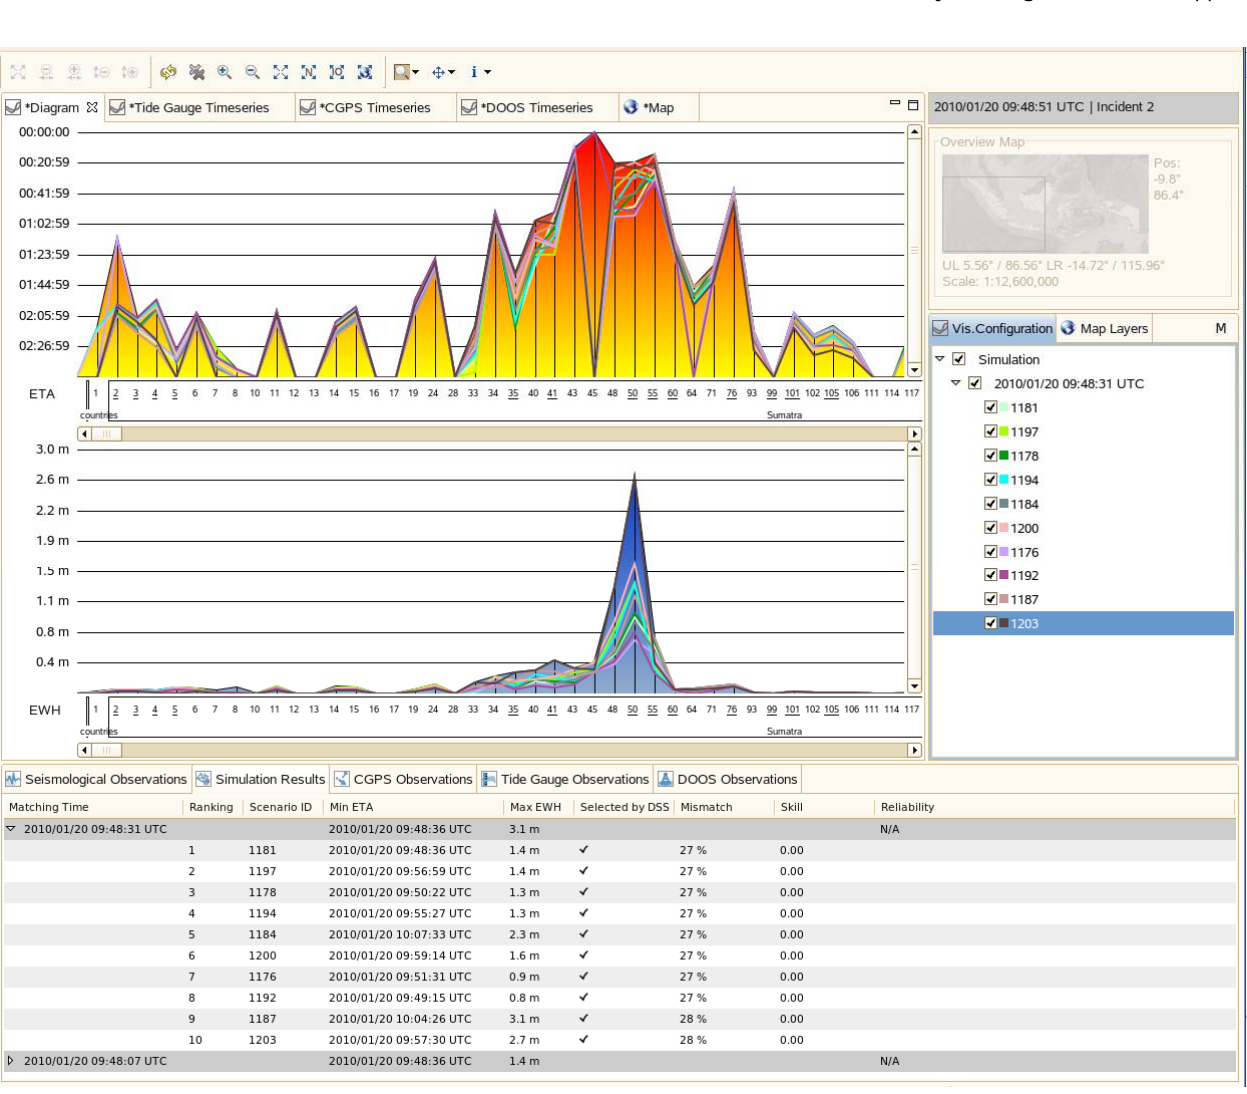
Fig. 5. Simulation Visualization Diagram in the Observation Perspective , showing Scenario Aggregation. Each curve represents ETA (estimated time of arrival) on the top diagram and EWH (estimated wave height) on the bottom diagram, respectively, for a single scenario along the coast (each number along the horizontal axis represents one coastal warning segment. The black curve shows the aggregated worst case for all scenarios selected in the simulation matching process for one set of observations.